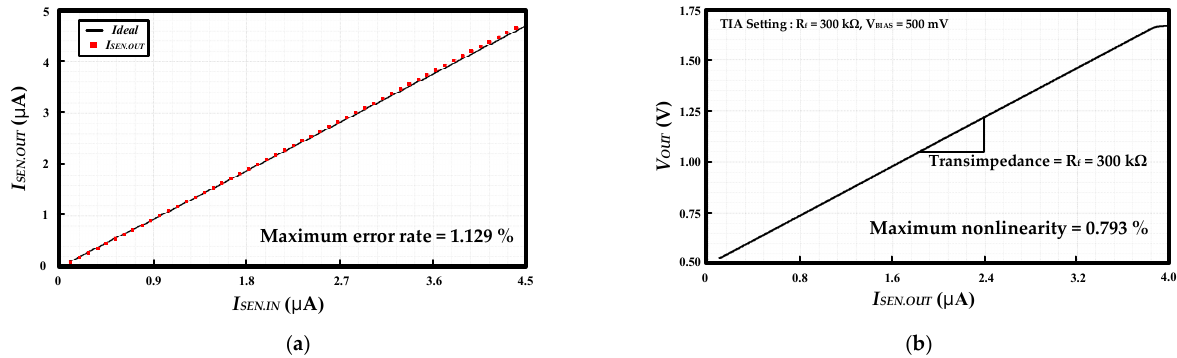
Figure 10. ( a ) Linearity simulation result of the sensing current; ( b ) linearity simulation result of the TIA.